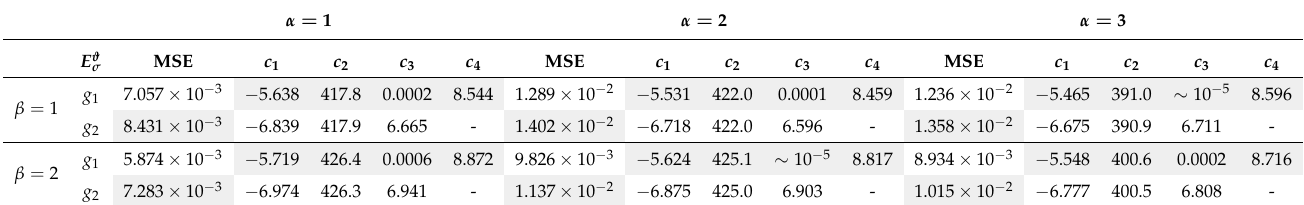
Table 4. DFN395. MSE and coefficients of the least square minimization with respect to E ϑ σ . α = 1 α = 2 α = 3 E ϑ σ